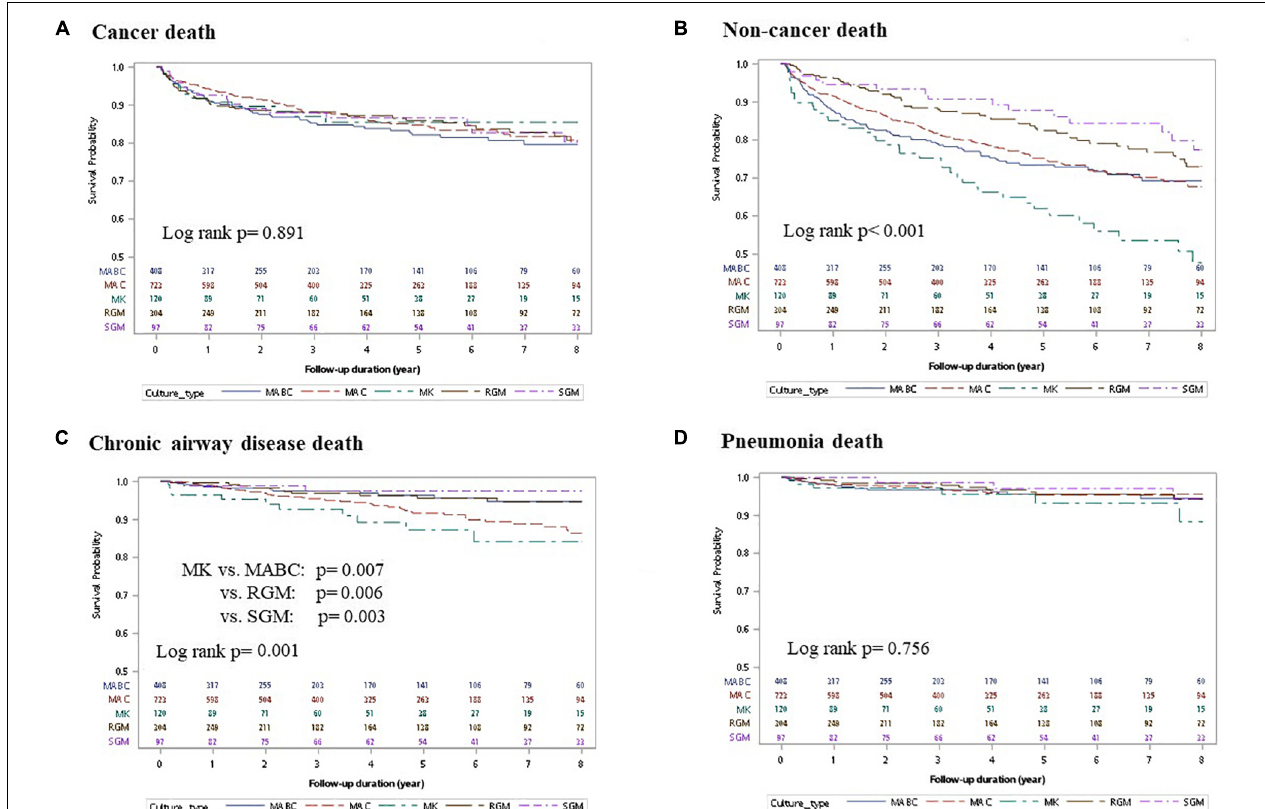
FIGURE 3 | Kaplan–Meier survival curves of nontuberculous mycobacterial lung disease (NTM-LD) according to different NTM species and different death causes. (A) Cancer-related death, (B) non-cancer-related death, (C) chronic airway disease-related death, and (D) pneumonia-related death. MABC, Mycobacterium abscessus complex; MAC, Mycobacterium avium complex; MK, Mycobacterium kansasii ; SGM, slow-growing